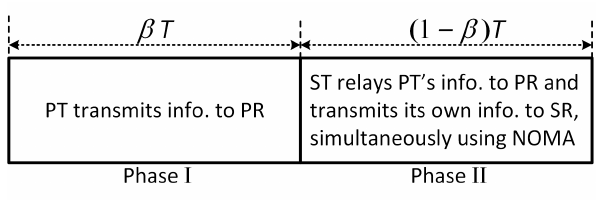
Figure 1. The cooperative network consisted of a primary user and secondary user. The secondary transmitter used PF as a relaying protocol.